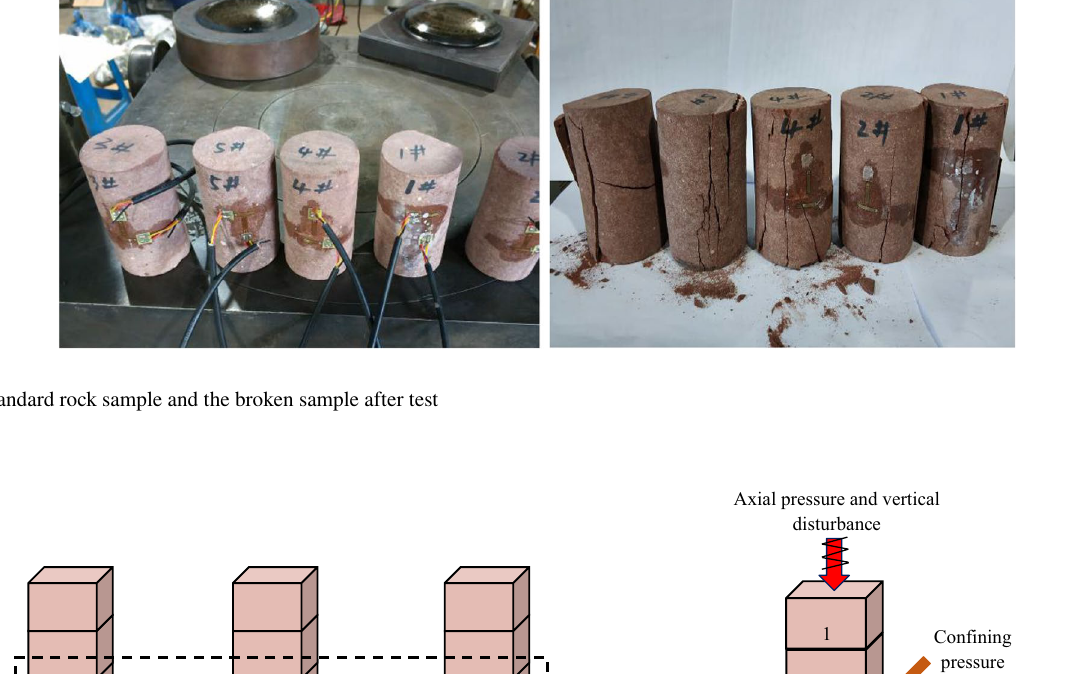
Intact sandstone